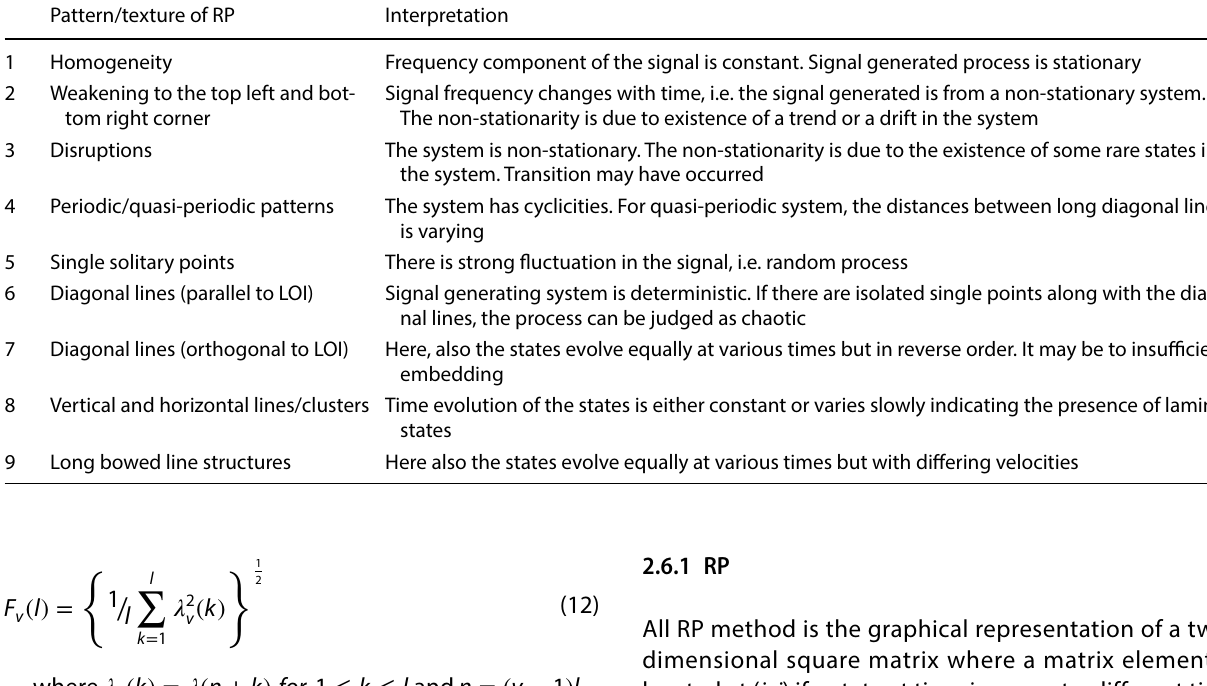
Table 1 Recurrence plot patterns and their meaning [33] Pattern/texture of